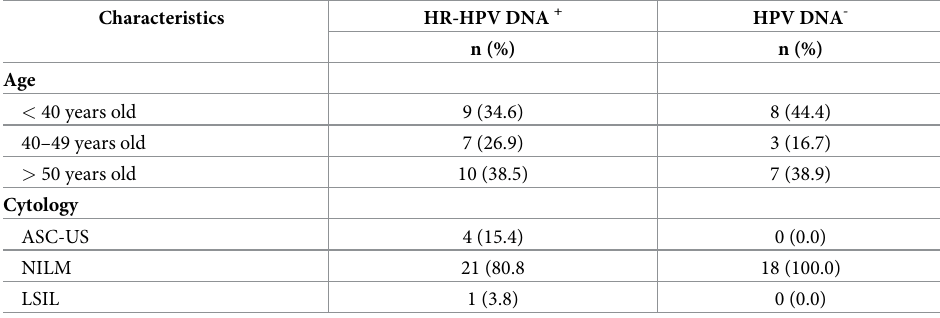
Table 1. Characteristics of the study participants (n =